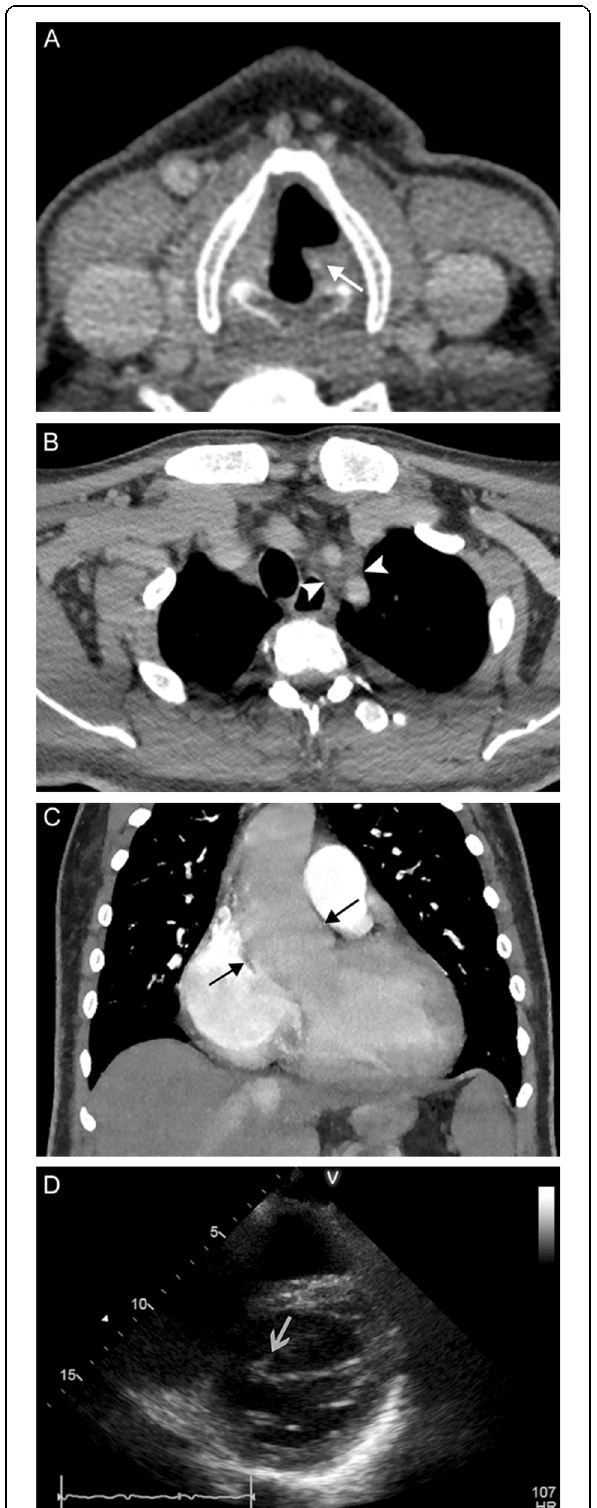
Fig. 21 Endocarditis. A 41-year-old previously healthy man presents with intermittent hoarse voice and unexpected weight loss. Axial contrast-enhanced CT images through the larynx ( a ) and mediastinum ( b ) reveal left vocal fold rotation (white arrow) and lymphadenopathy surrounding the left carotid and subclavian arteries (white arrowheads). A coronal CTA image ( c ) reveals an ascending aortic aneurysm (black arrows). Echocardiogram ( d ) reveals a bicuspid valve with vegetations (gray arrow) and severe aortic stenosis. Overall, findings are consistent with compression/ stretching of the left recurrent laryngeal nerve due to reactive lymphadenopathy and a dilated aortic arch in the setting